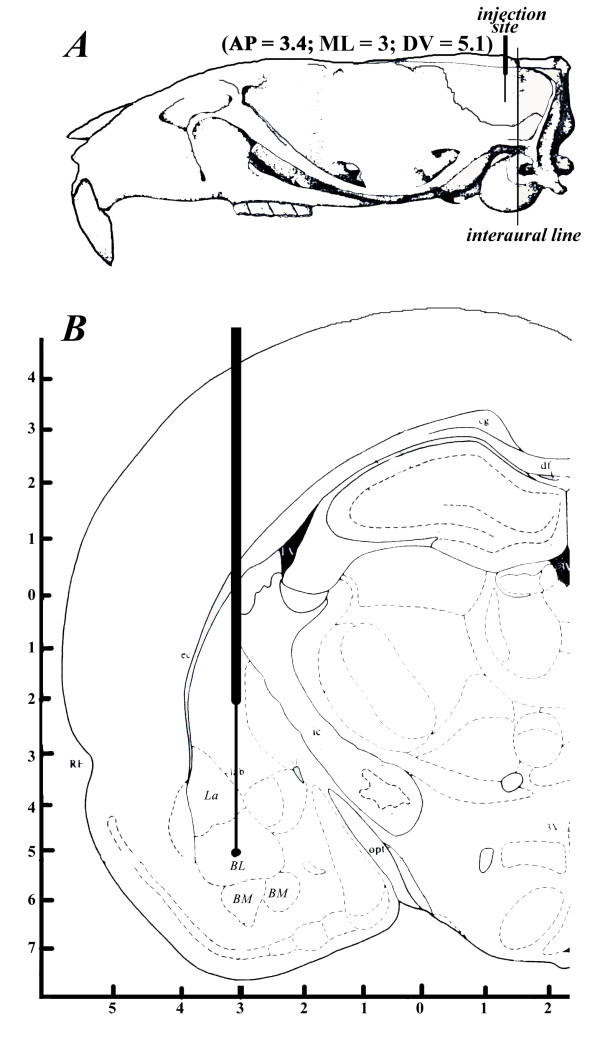
Dorsal and lateral views of the skull of a 150 gr male Syrian golden hamsters. The position of the guiding canula between the horizontal plane passing through bregma and lambda and that of the interaural line is shown (A) along with this position leading to the target site, i.e. BLA complex (B).